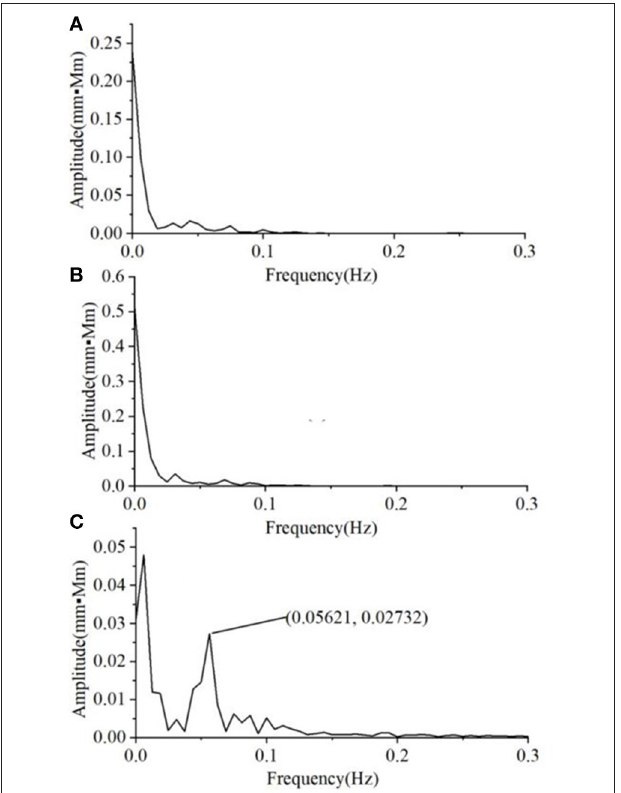
FIGURE 5 | The typical Oxy magnitude spectrum curve from a representative individual in each of three groups, i.e. (A) HCS, (B) MD, and (C) A&D. Note that the magnitude is almost zero at the range of 0.3–16.0Hz and not shown in the